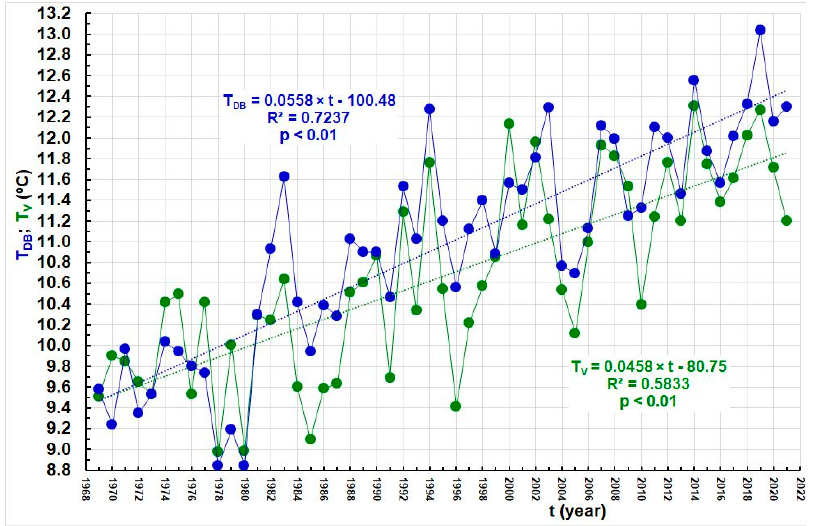
Figure 2. Series of mean annual water temperatures of the Drava at the station Botovo, T DB , and air temperatures at the GMP Varaždin, T V , from 1969–2021.